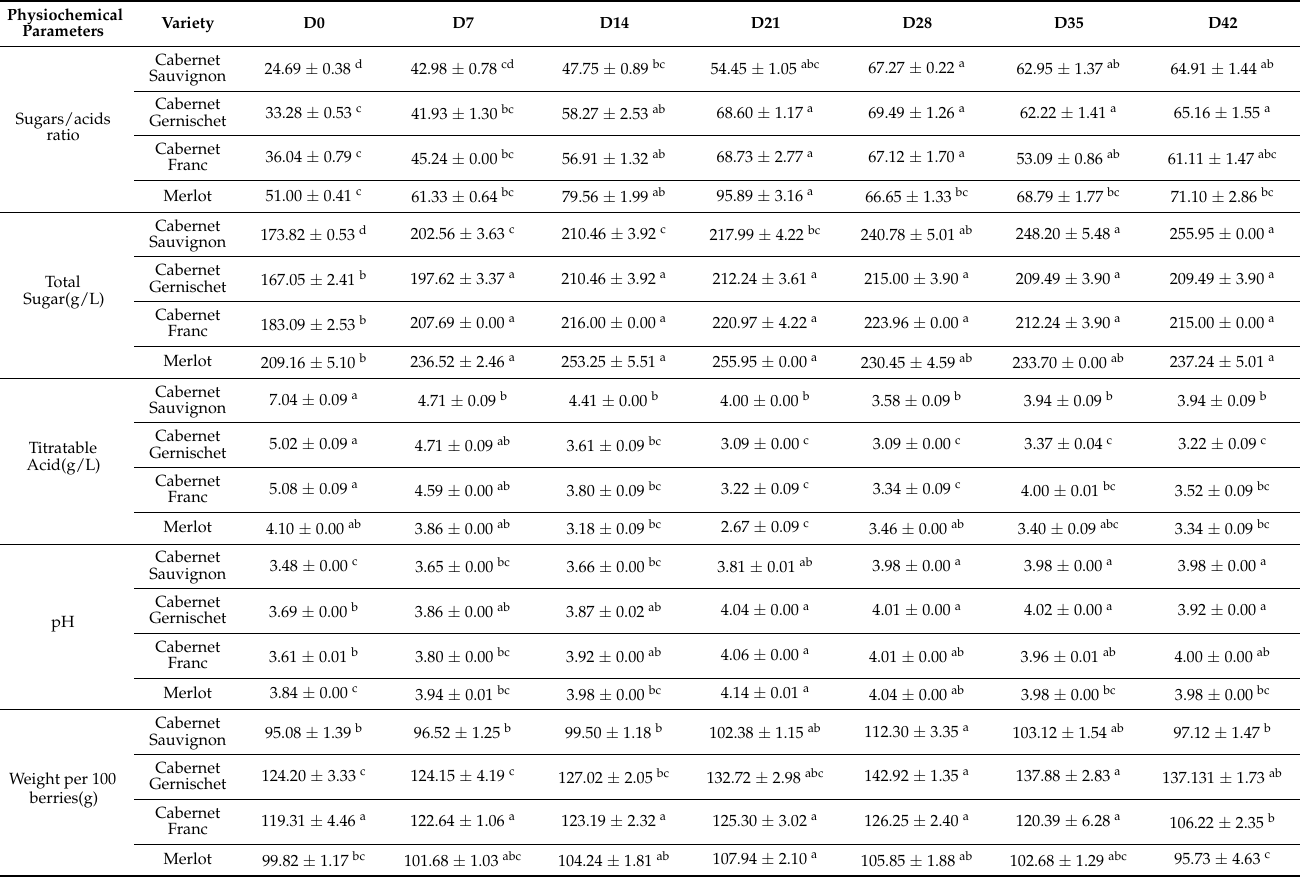
Table 1. B Physicochemical parameters of the grapes at different maturity